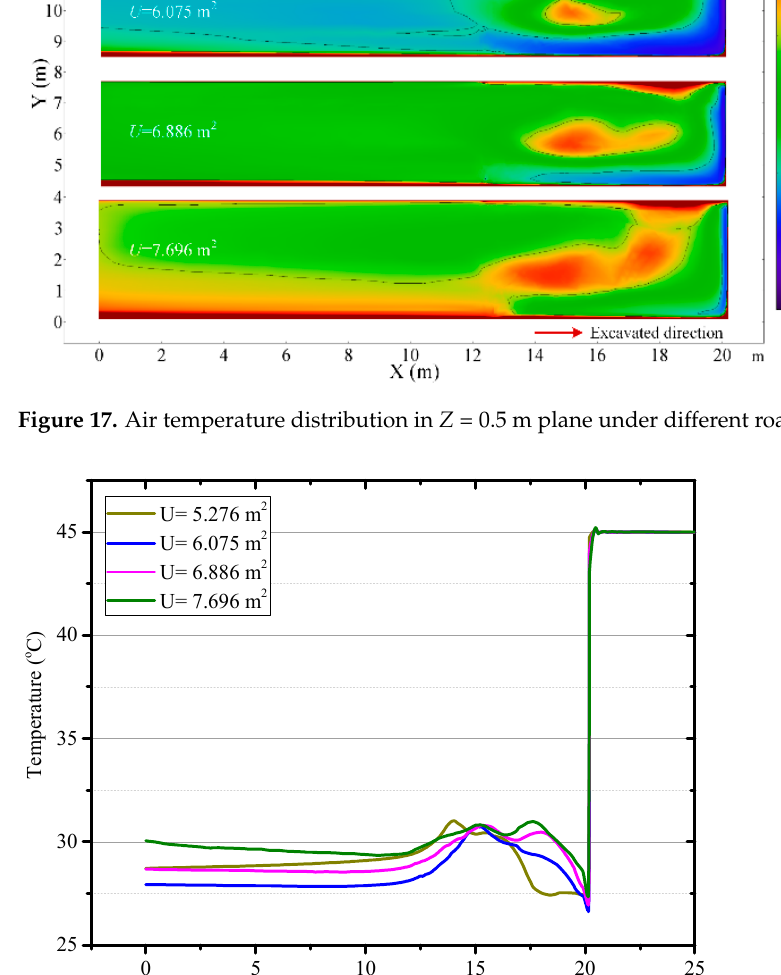
Figure 18. Air temperature in central axis of roadway ( Z = 0.5 m) under different roadway section size.